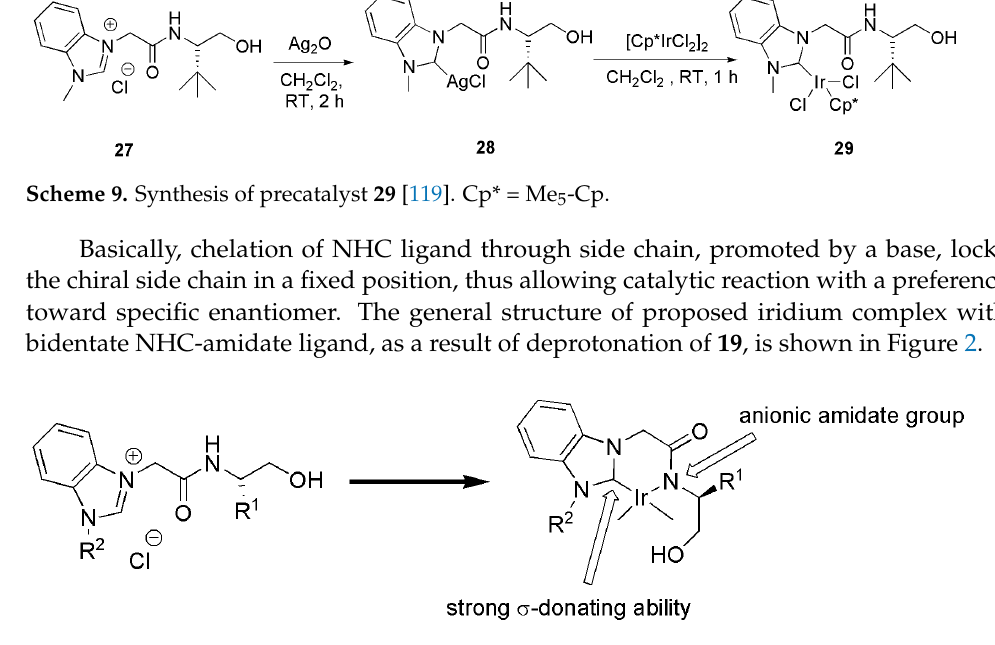
Figure 2. Proposed structure of iridium complex with NHC ‐ amidate ligand [119].